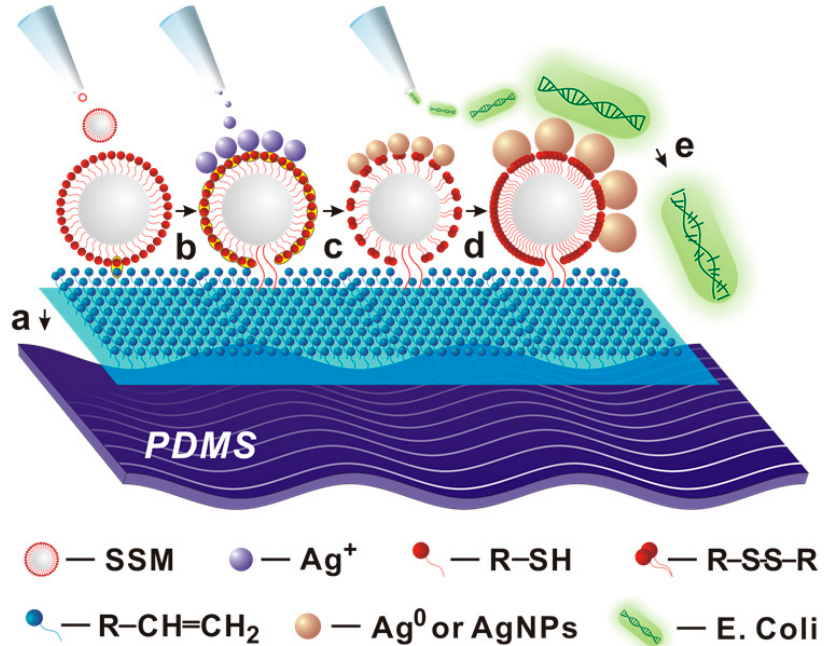
Schematic illustration of procedures for preparation of polydimethylsiloxane (PDMS)-supported silver nanoparticles (AgNPs) against E. coli . a ) silica microspheres (SMs) were generated by the hydrolysis of 3-Mercaptopropyl trimethoxysilane (MPTMS); b ) the SMs were assembled on the surface of PDMS by thiol-vinyl click reaction; c) the silver ions were reduced by the thiols groups; d) more and more silver atoms assembled together into AgNPs; e) PDMS-supported